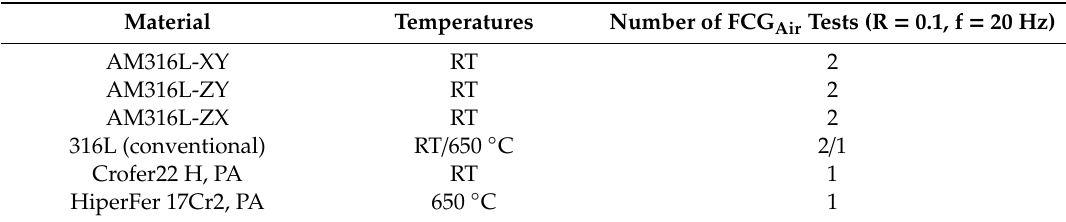
Table 5. Detailed test matrix of the fatigue crack growth (FCG) experiments. Material